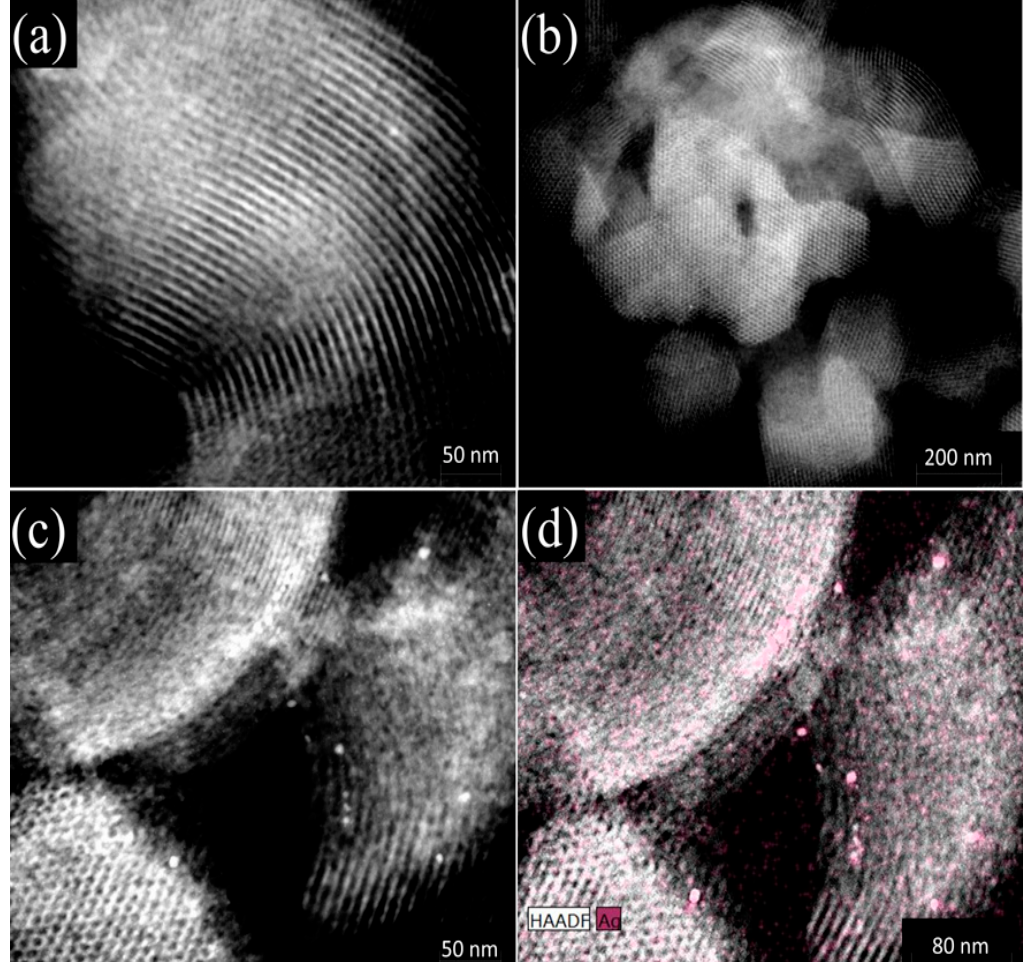
Figure 3. ( a , b ) High-angle annular dark-field scanning transmission electron microscopy (HAADF- STEM) micrograph for pure SBA-15; ( c ) HAADF-STEM and ( d ) HAADF-STEM coupled with